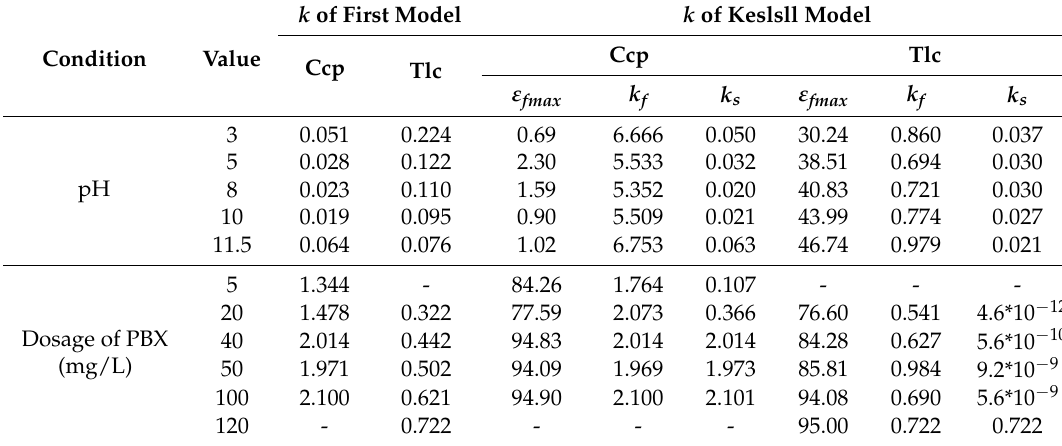
Table 2. Kinetics simulation results of talc and